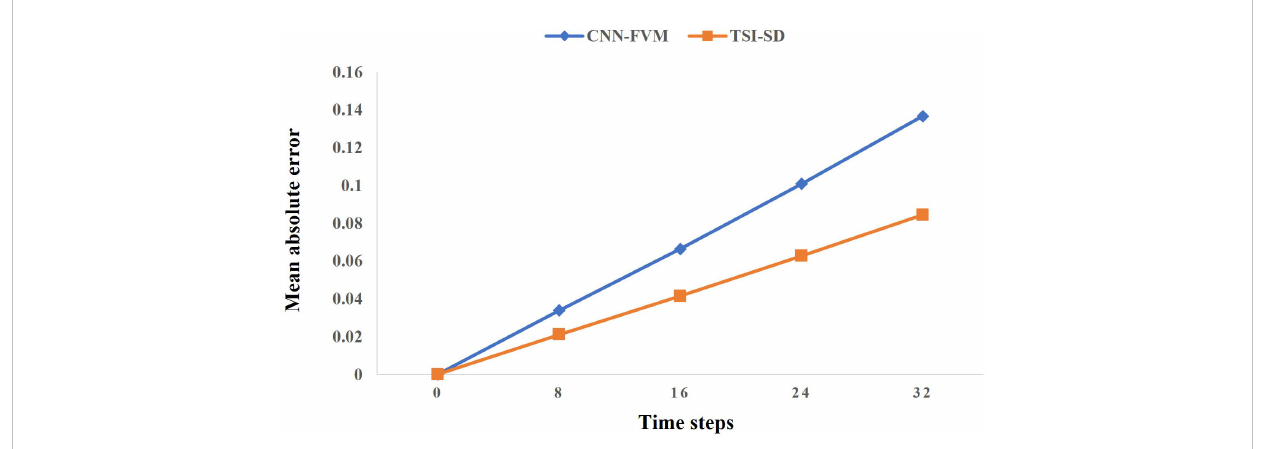
FIGURE 5 Results of our solver compared to CNN-FVM solvers by Zhuang Zhuang et al. (2021). The orange line represents our error in the 32-step iteration prediction, and the blue line represents the error of CNN-FVM